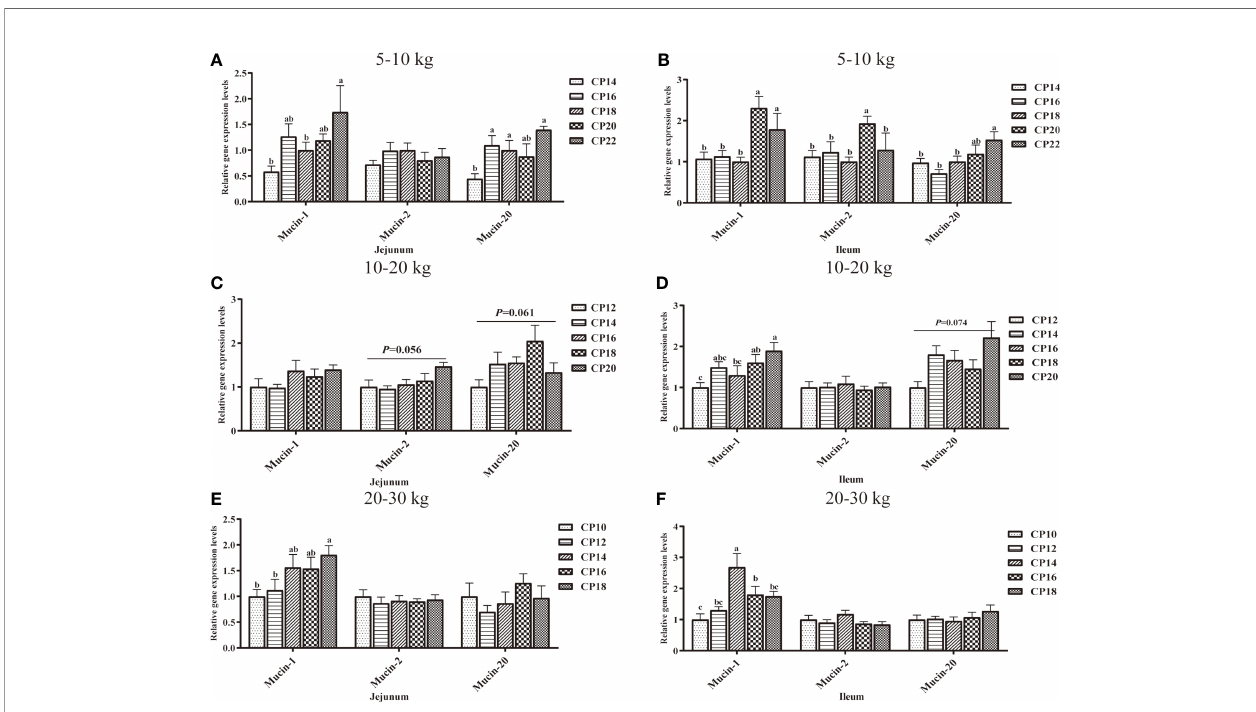
FIGURE 9 | Effects of dietary crude protein (CP) levels on the mucin-related gene expression in the small intestinal mucosa of Huanjiang mini-pigs during 5 − 10 kg ( A , jejunum; B , ileum), 10 − 20 kg ( C , jejunum; D , ileum), and 20 − 30 kg ( E , jejunum; F , ileum) growth stages. Data are presented as means ± SE ( n = 6 − 8 per group). Different superscript letters indicate signi fi cant differences among the fi ve groups ( P <